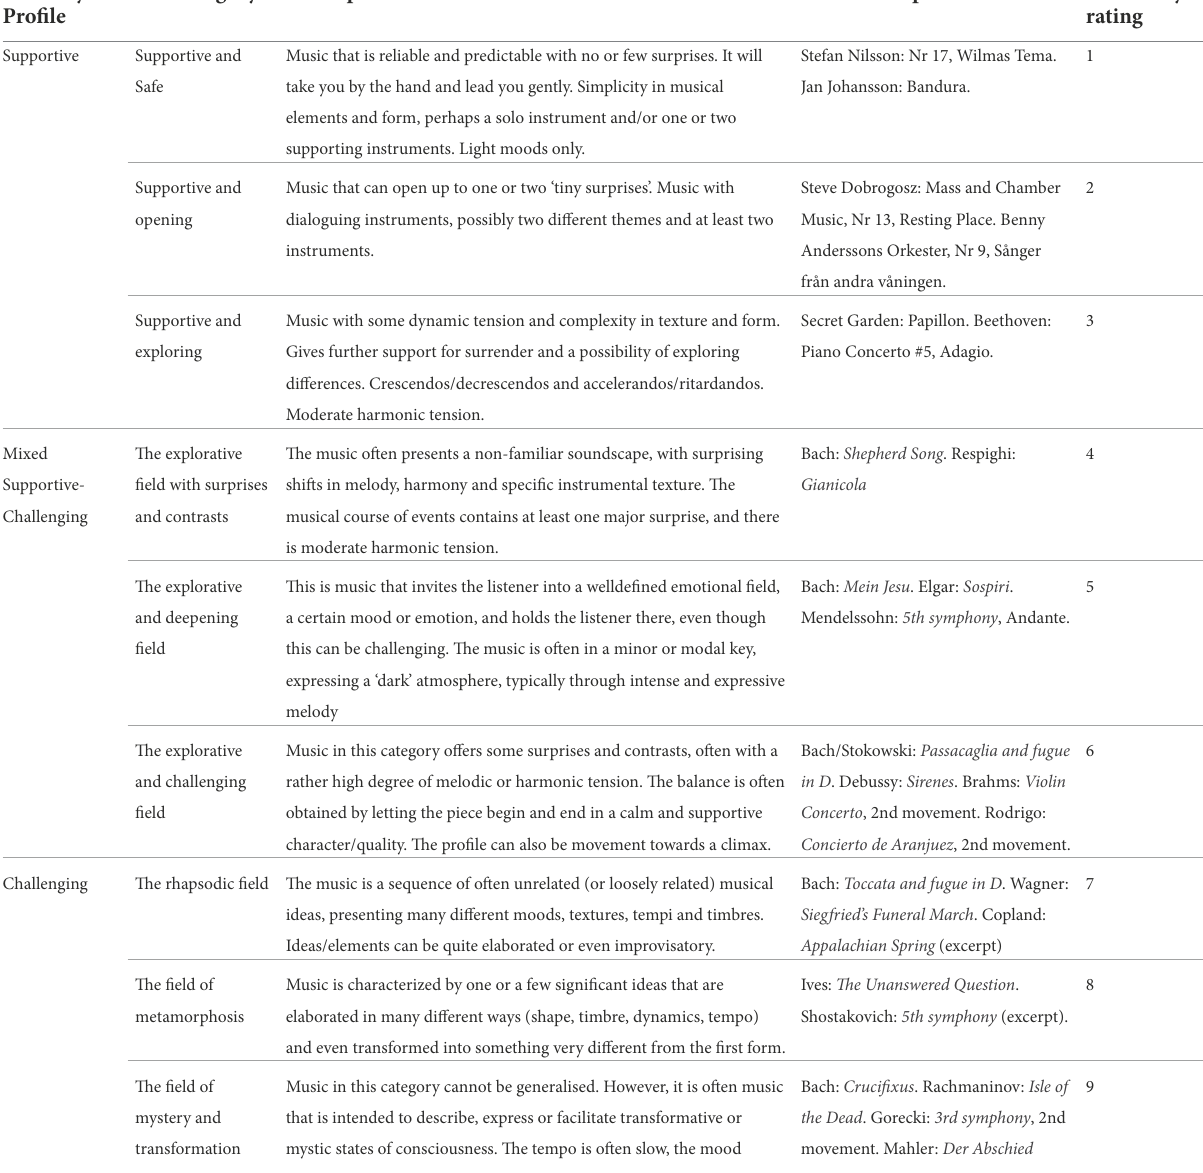
The table shows a full description of the three intensity profiles and their nine sub-categories in the taxonomy. Reprinted with permission from Bonde, L.O. and Wärja,